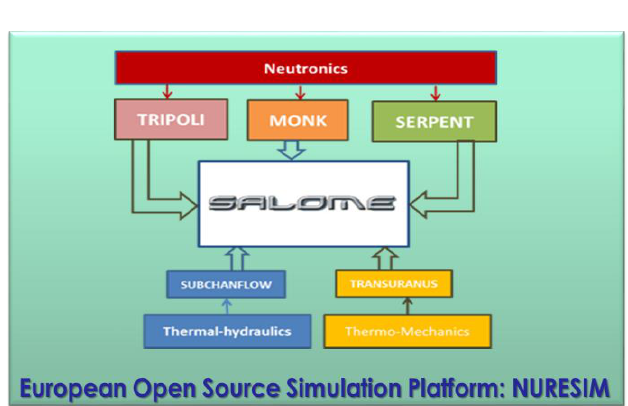
Figure 3: NURESIM platform and Codes coupled using ICoCo